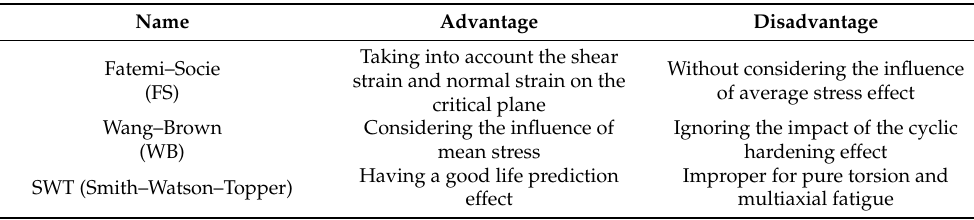
Table 1. Advantages and disadvantages of typical critical-damage-plane functions.